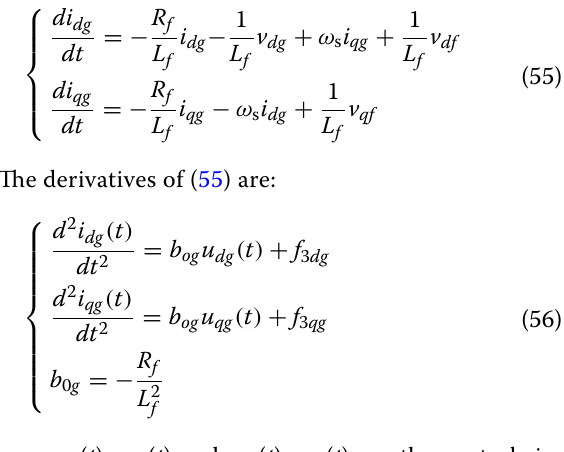
The schematic of the GSC vector control is presented in Fig. 9. From the actual and reference of the DC-link volt- ref ) , the reference active power exchanged age ( V bus , V bus ref with the network ( P g ) is specified using the PI control- ler. The current control loops are also implemented using FFOADRC.